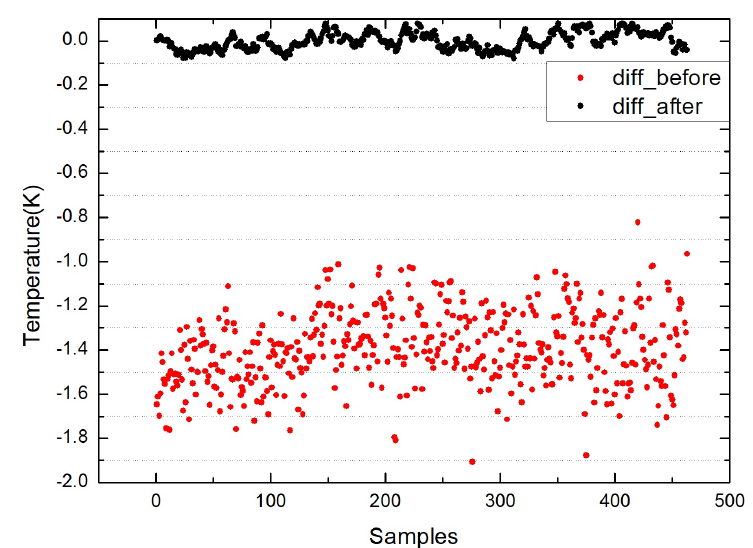
Figure 10. Deviation before correction of the infrared thermometer (diff_before) and after correction (diff_after) shows the comparison between the output water surface temperature value and the measured value of FLUKE1524 and the deviation value of the two after the derivation of the algorithm in this